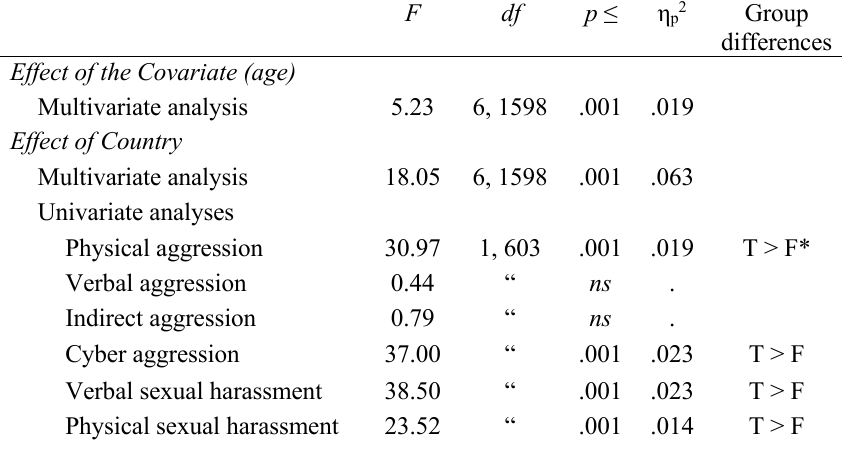
Results from a Multivariate Analysis of Covariance (MANCOVA) with Age as Covariate, Country and Sex as Independent Variables, and Victimization from Aggression and Sexual Harassment as Dependent Variables (N = 1,597), cf. Figures 1 and